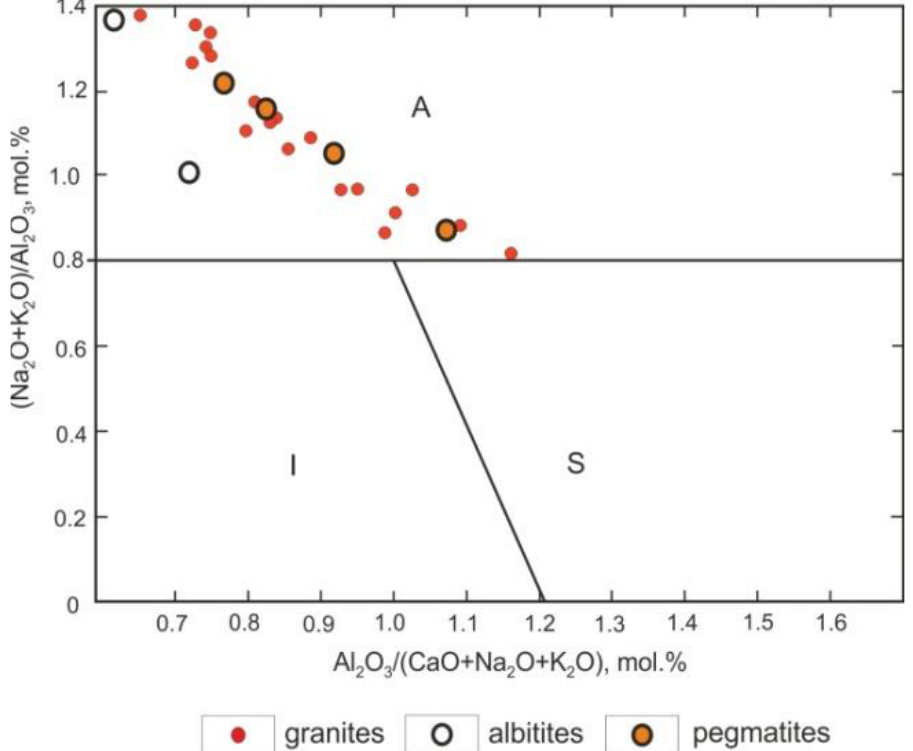
Figure 13. (Na 2 O + K 2 O)/Al 2 O 3 vs. Al 2 O 3 /(CaO + Na 2 O + K 2 O) diagram for rocks of the Somnitelnyi massif and Tommot deposit. Fields on the diagram are from [59]. I, S, A — petrographic types of granitoids.